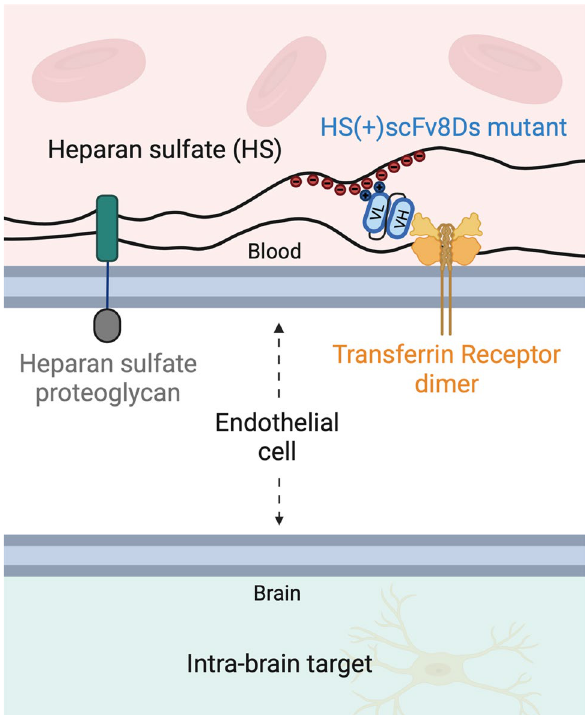
Figure 1. Illustration depicting the hypothetical scenario of HS-mediated brain uptake of TfR binders. This study attempted to increase the brain uptake of the TfR-binder scFv8D3 by introducing extra HS binding sites, creating the HS(+)scFv8D3 mutant